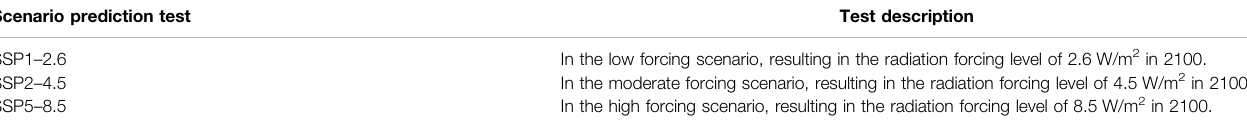
TABLE 2 | CMIP scenario experimental